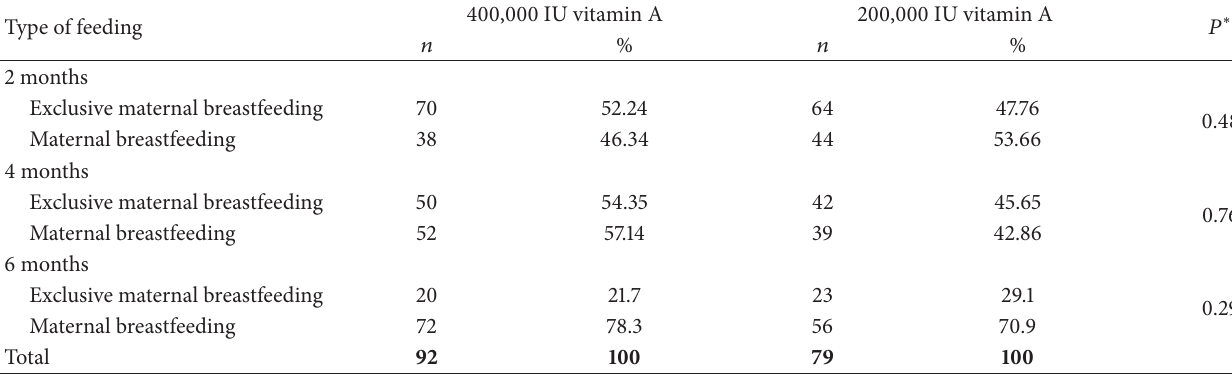
Table 4: Distribution of maternal breastfeeding in children after six months by supplement group, Recife, 2008-2009.